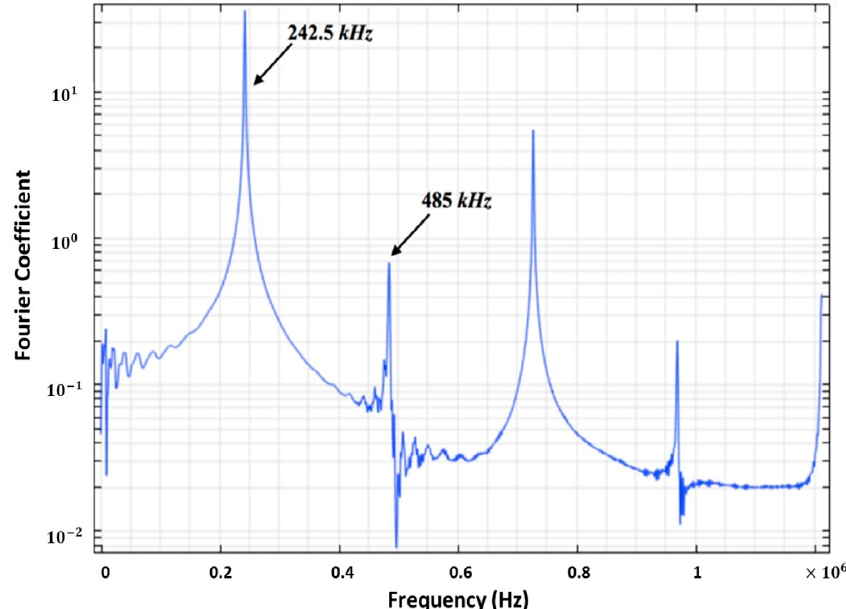
Figure 3. The calculated frequency spectrum at the tip of the silicon-based three-horn. The designated harmonic frequency from COMSOL Multiphysics 5.4 is 485 kHz. As expected, 242.5 kHz is the corresponding subharmonic frequency.